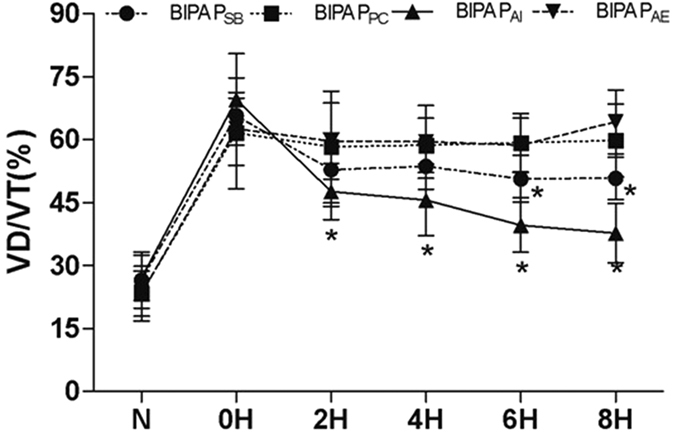
Time course of the end- expiratory lung volume (EELV) in experimental groups (n = 6 per group).BIPAPSB = biphasic positive airway pressure with SB; BIPAPPC = biphasic positive airway pressure with muscles paralysis; BIPAPAI = biphasic positive airway pressure with inspiratory muscles activity; BIPAPAE = biphasic positive airway pressure with expiratory muscles activity. SB = spontaneous breathing; *P < 0.05, vs. other groups.